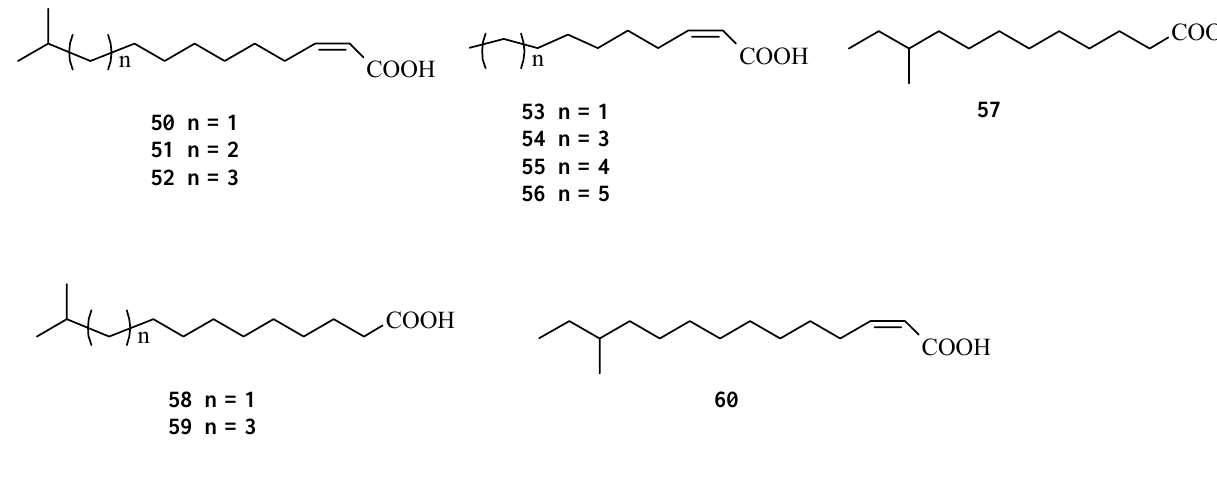
Figure 4. Fatty acids isolated from various bacteria and acting as diffusible signal factor in communication with other